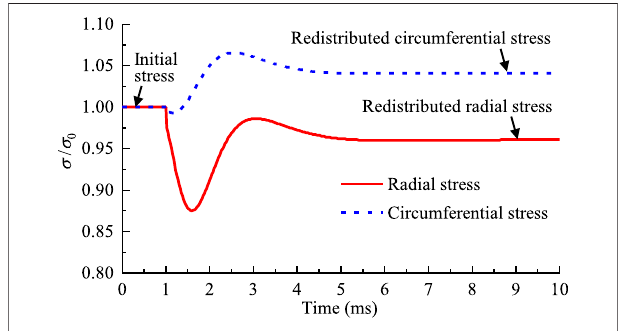
FIGURE 3 | Stress waves induced by the rapid in situ stress release in a circular excavation (Yang J. H. et al., 2018).